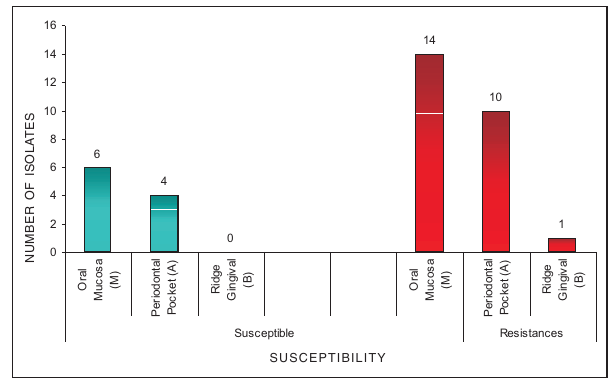
Fig. 4b - Susceptibility of Candida non albicans isolates to Amphotericin B for sites collected.